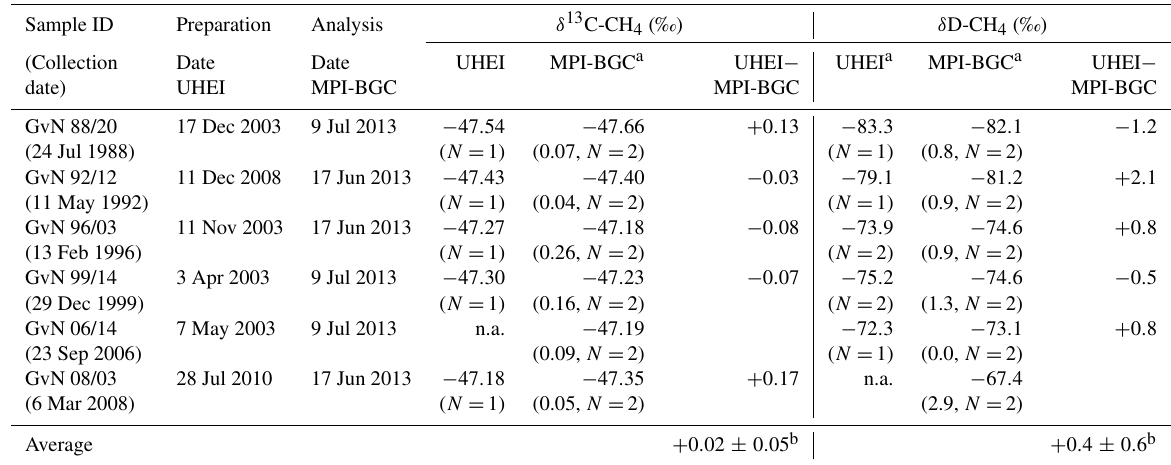
Table 4. Result of intercomparison of δ 13 C-CH 4 and δ D-CH 4 measurements between UHEI and MPI-BGC. n.a.: not